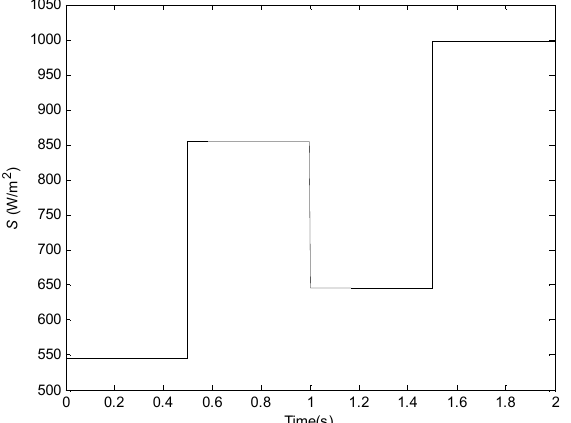
Figure 33. Irradiance curve for the comparison experiment.